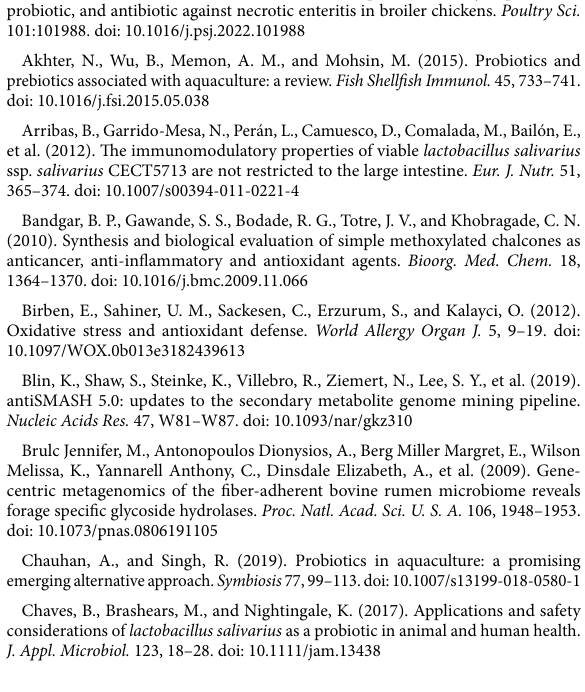
SUPPLEMENTARY FIGURE S1 Histogram of Gene Ontology (GO) enrichment analysis results for the L. salivarius S01 genome. SUPPLEMENTARY FIGURE S2 Histogram of Kyoto Encyclopedia of Genes and Genomes (KEGG) enrichment analysis results for the L. salivarius S01